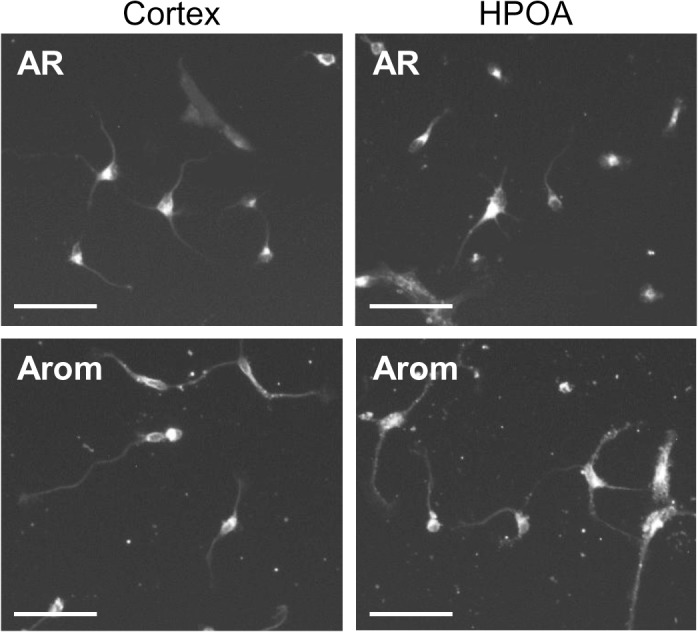
Immunohistochemical staining of untreated cortical and HPOA neurons in cultures grown for 3 days (DIV3).Shown is immunofluorescence labeling for androgen receptor (AR) and aromatase (Arom). Scale Bar = 50 μm.